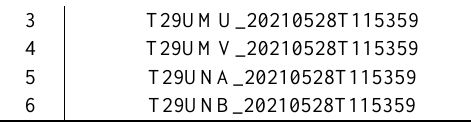
Table 1 . Sentinel-2 tiles acquired.